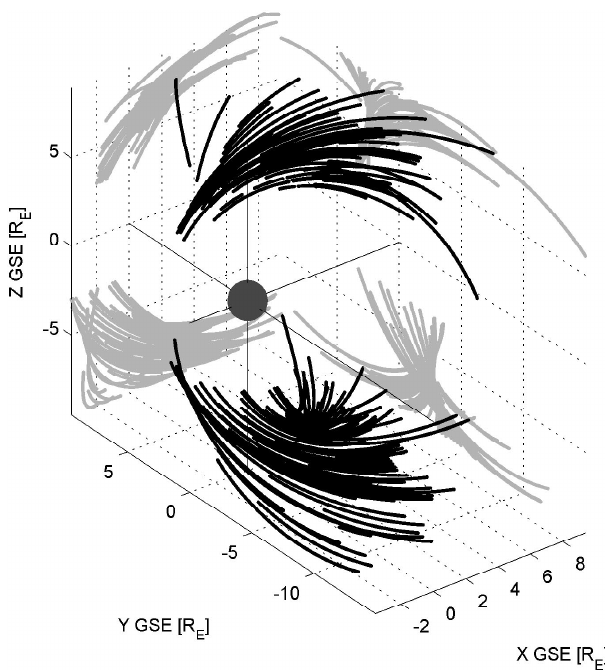
Fig. 2. Distribution of data points used in the study. Orbits are shown in black, projections on the Y-Z and X-Z planes are shown with grey lines. The axes are Geocentric Solar Ecliptic (GSE) coor- dinates in units of R E . The sun is towards positive